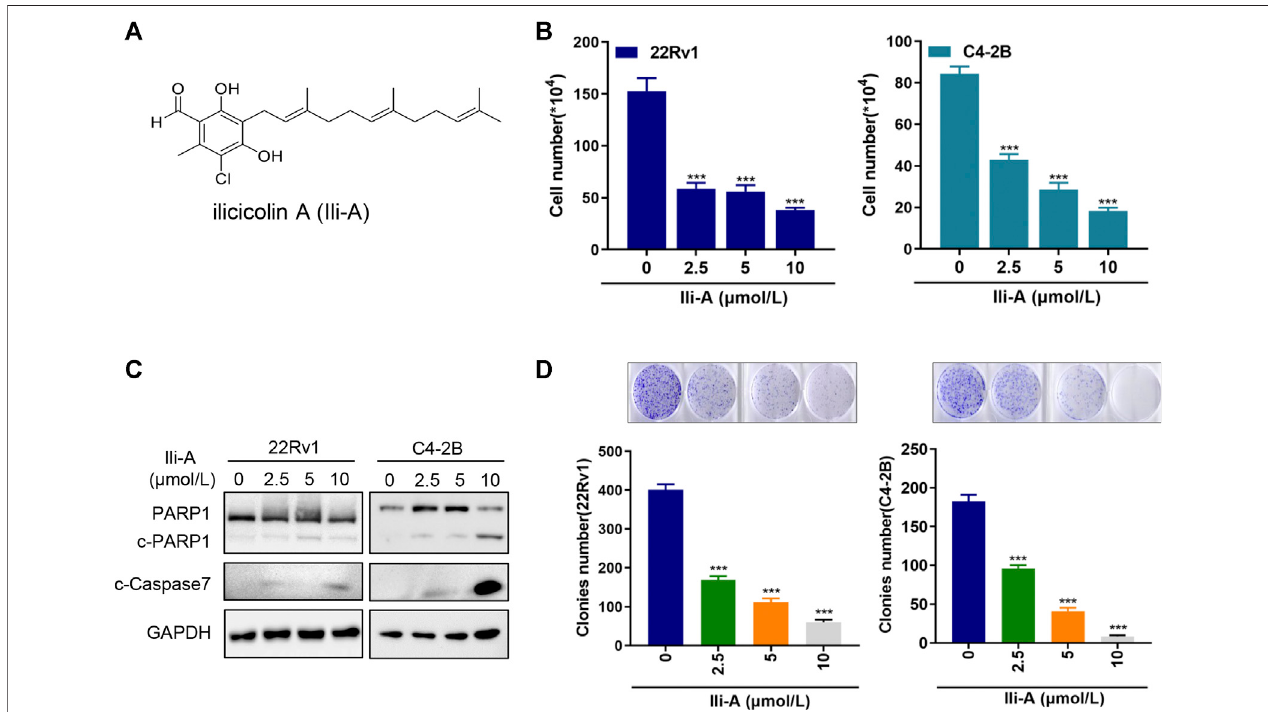
FIGURE1| Ili-Ainhibitssurvivalofcastration-resistantprostatecancercellsand inducestheirapoptosis. (A) Chemicalstructure ofIli-A. (B) 22Rv1cellsandC4-2B cellsweretreatedwithvehicleorIli-Aasindicated.After96h,thetotalnumberofviablecellswascountedwithacellcounter. (C) Immunoblottingoftheindicatedproteins in22Rv1andC4-2BcellstreatedwithvehicleorIli-Afor48 h. (D) 22Rv1cellsandC4-2Bcellsweretreatedwithvehicle(DMSO)ortheindicatedconcentrationsofIli-Afor 12 days, after which colony formation was